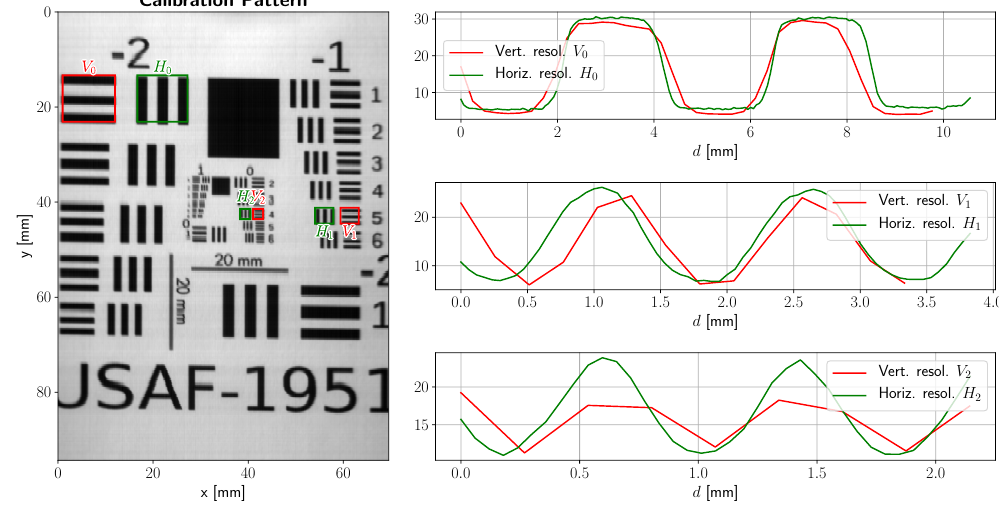
Figure 11. 1951 USAF resolution test chart, average reflectance (left) and cross-section intensities at different band widths (right). Total resolution is limited by vertical (actuator) resolution, which could be improved in future versions by improving mechanical resolution and actuator repeatability. Best viewed in color.